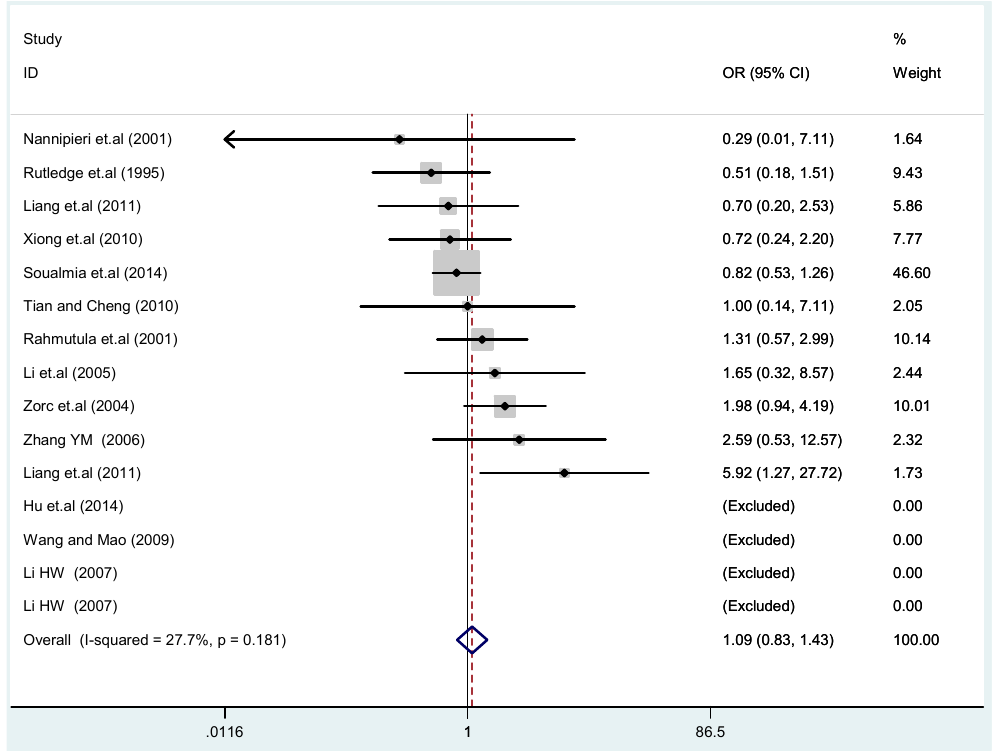
Figure 6. Forest plot of overall population of T2238C recessive model CC vs. (TT + TC).